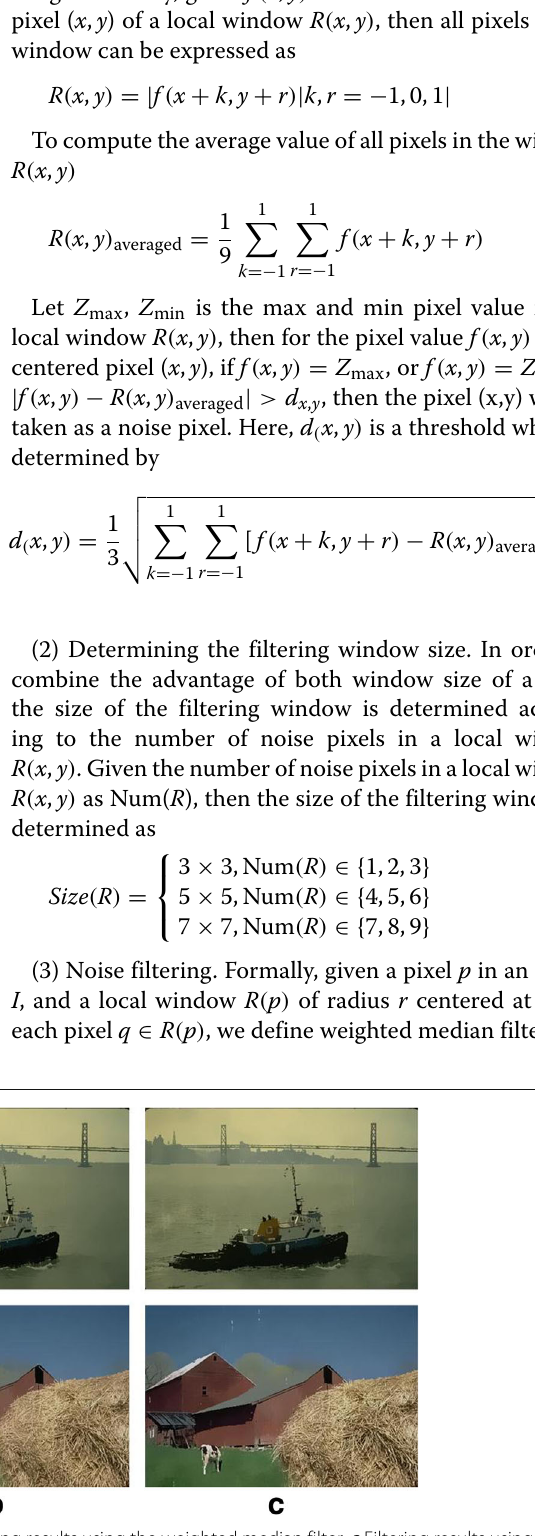
Fig. 2 Results with different filtering method. a Input rainy images. b Filtering results using the weighted median filter. c Filtering results using guided